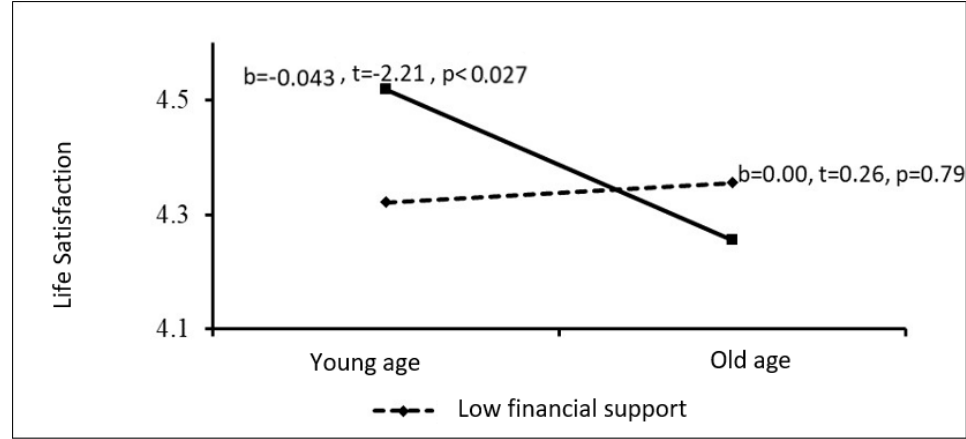
Figure 2. Financial parental support as a moderating variable between age and life satisfaction.